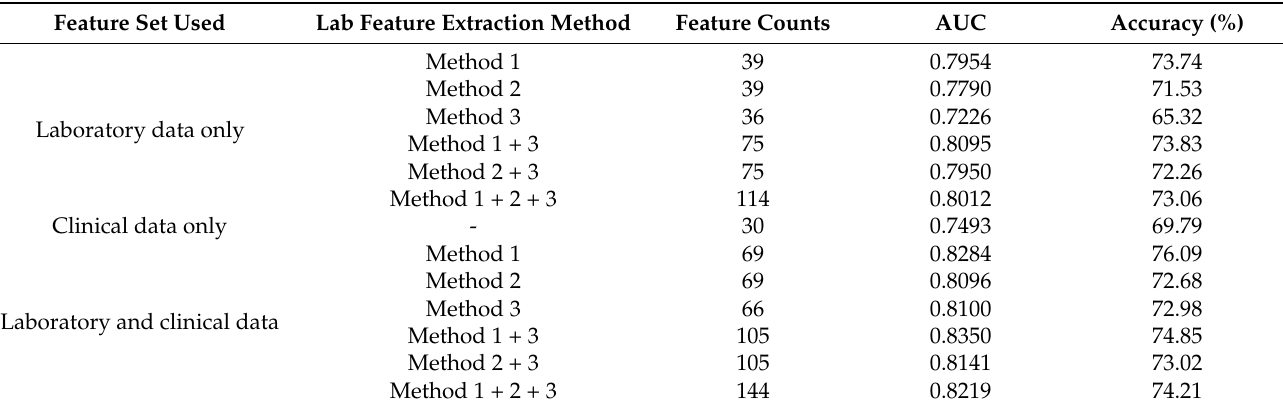
Table 1. Identification of the selection of data and methods for machine learning analysis of subjects. Feature Set